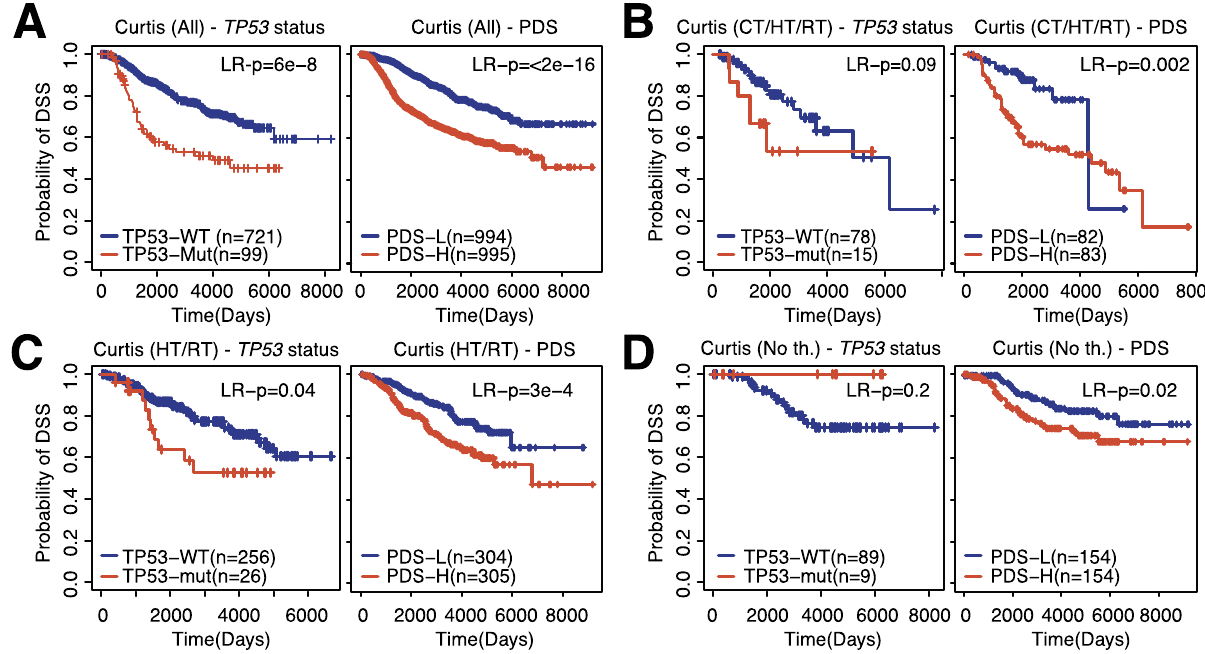
Figure 4. PDSs in the METABRIC/Curtis dataset. ( A ) KM plot evaluating the association of TP53 mutation status (left) or PDS (right) with survival in the METABRIC/Curtis dataset (all patients). ( B ) Association of TP53 mutation status (left) or PDS (right) with survival for patients receiving a combination of chemotherapy therapy, hormone therapy, and radiotherapy. ( C ) Association of TP53 mutation status (left) or PDS (right) with survival for patients receiving a combination of hormone therapy and radiotherapy. ( D ) Association of TP53 mutation status (left) or PDS (right) with survival for patients not receiving any treatment. LR p-value calculated between TP53 groups using Log-rang tests, Cox-p p-value calculated using Coxph regression using PDSs as continuous variable, DSS disease-specific